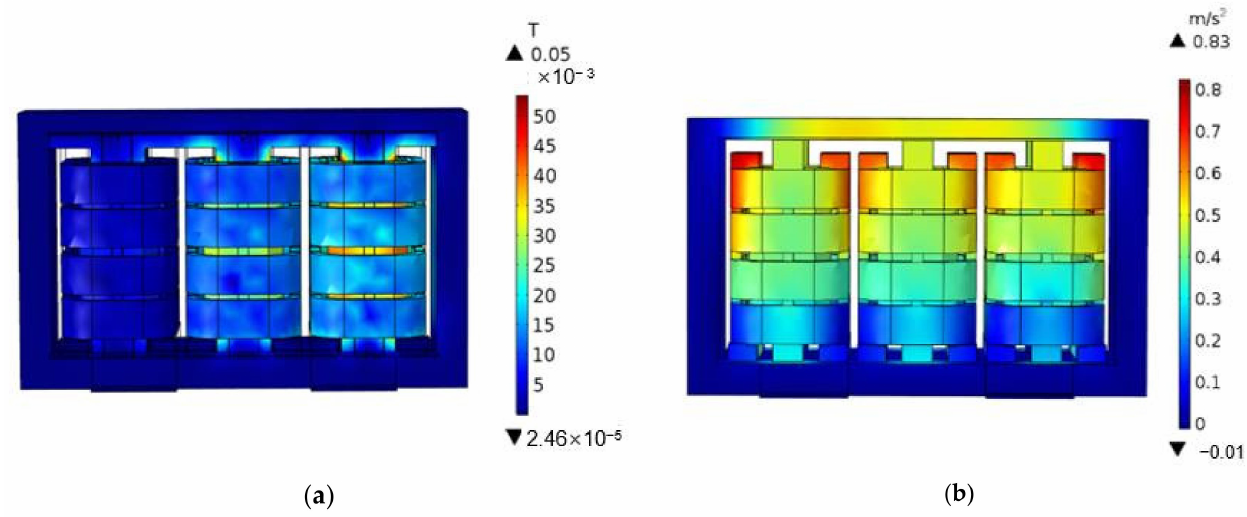
Figure 11. Analysis results of magnetic field and acceleration at rated current. ( a ) Leakage magnetic field distribution; ( b ) Acceleration distribution of winding and